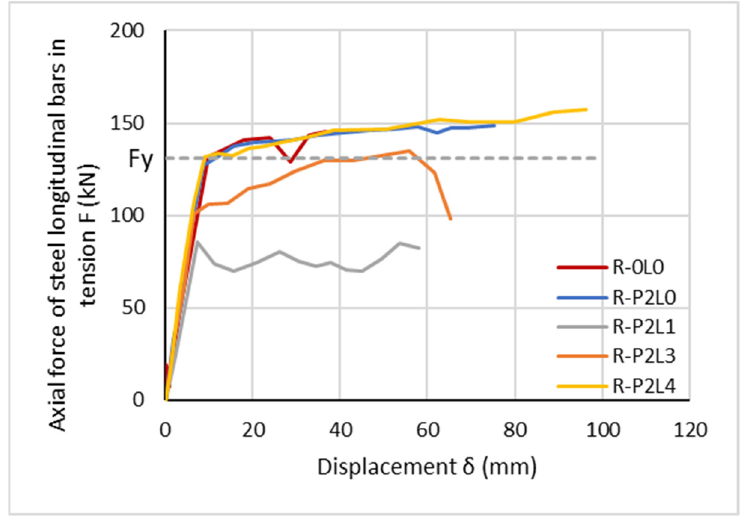
Figure 5. Comparative F- δ curves of retrofitted columns.